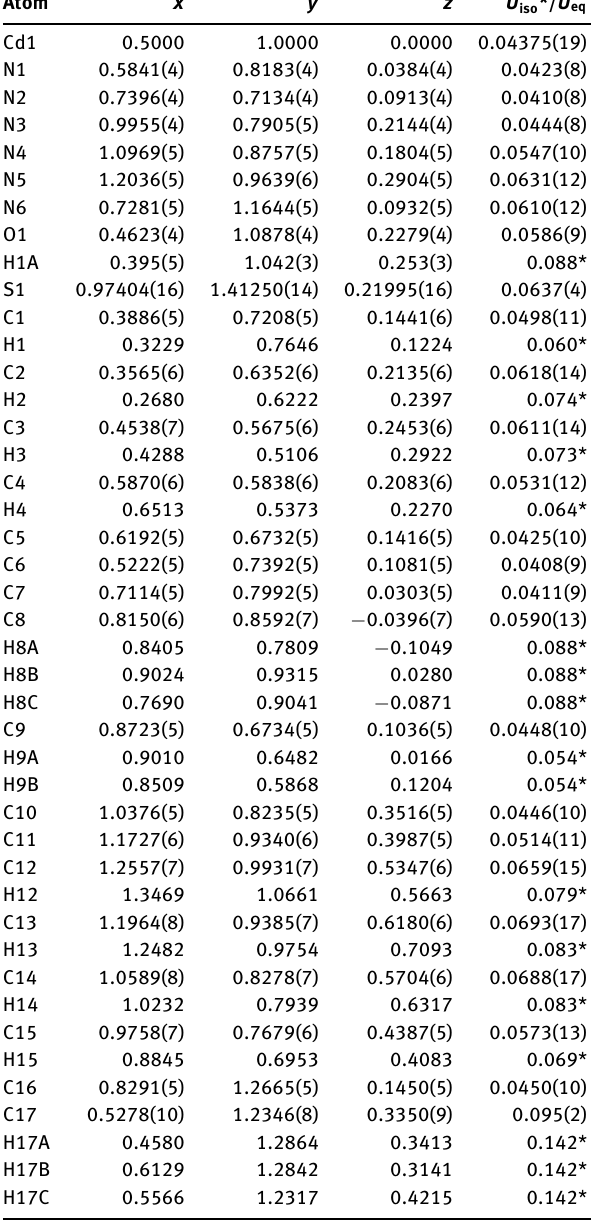
Table 2: Fractional atomic coordinates and isotropic or equivalent isotropic displacement parameters (Å 2